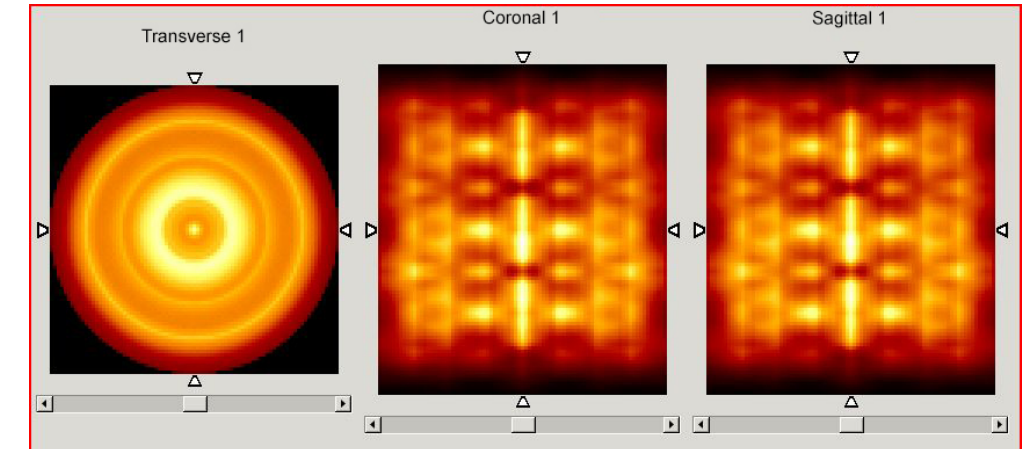
Figure 3. Normalization tomogram of ClearPET: backprojection of the measurement of a homogeneous cylinder